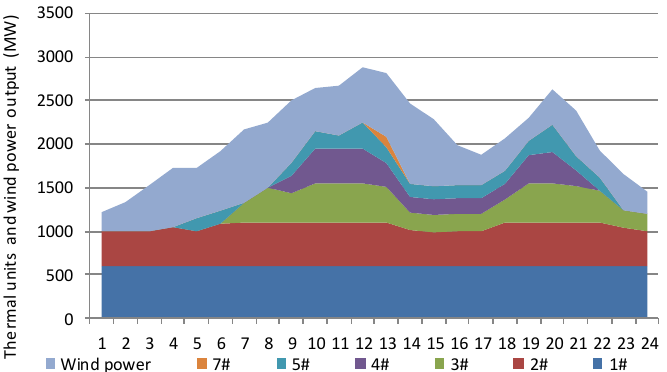
Figure 3. Thermal units and wind power output in Case